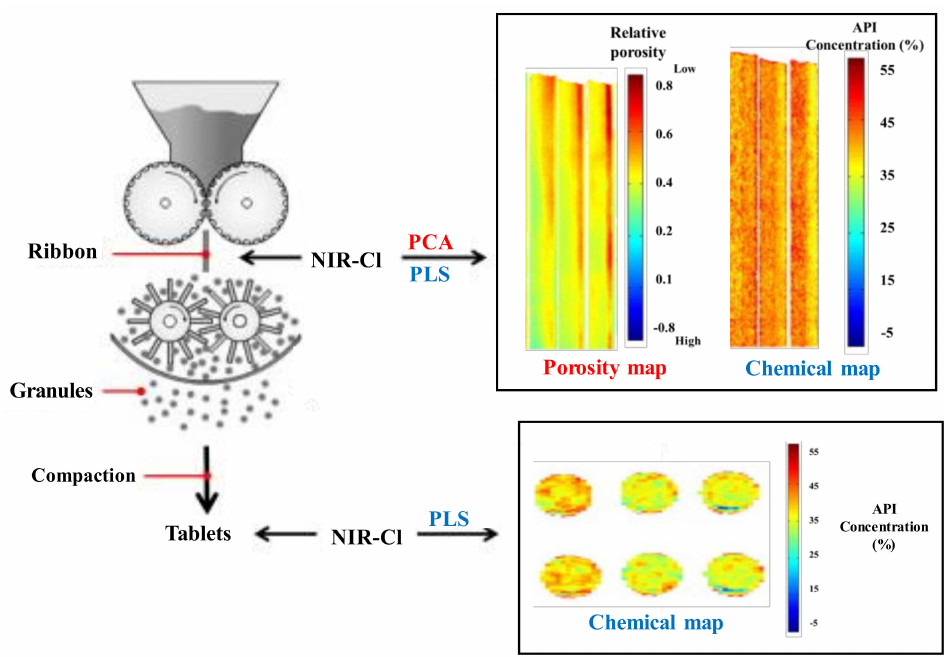
Figure 15. Summary of the use of NIR in roller compaction and tableting processes. Principal component analysis (PCA) and Partial least squares (PLS) were used to monitor the porosity and content uniformity of the ribbons and tablets, respectively [158]. The figure was slightly modified, with permission from